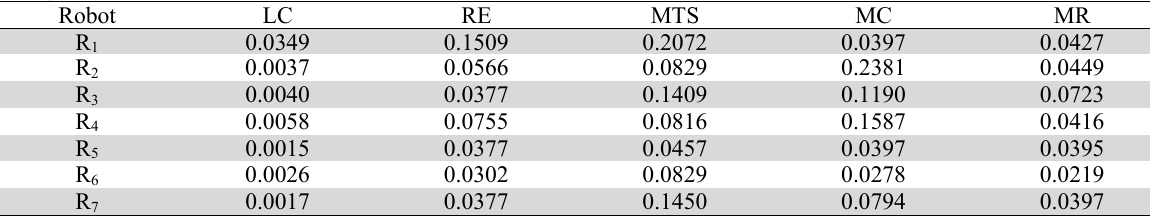
Weighted normalized decision matrix